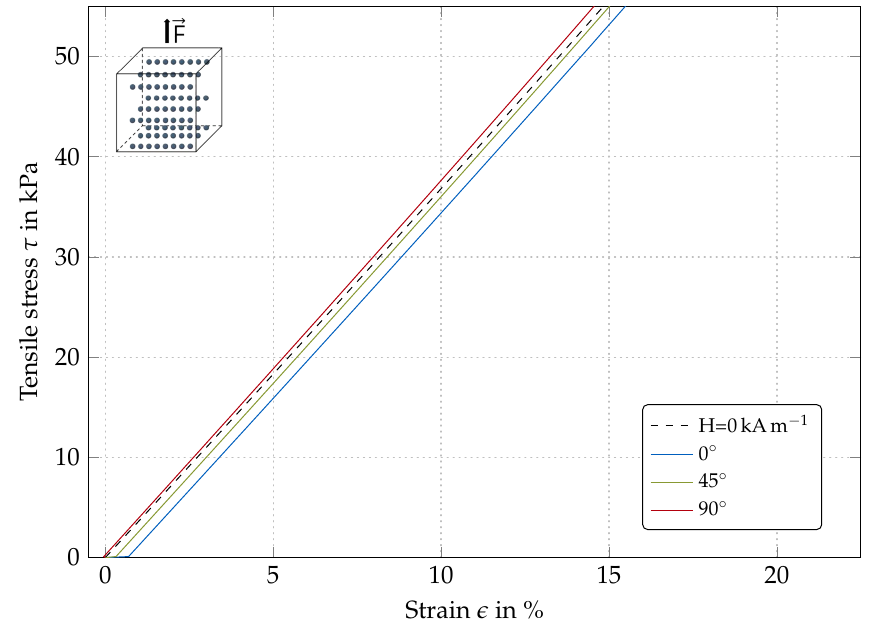
Figure 6. Simulated stress-strain behavior of an anisotropic MR elastomer with pre-structuring directions perpendicular to direction of force application for different magnetic field orientations (H = 30kAm − 1